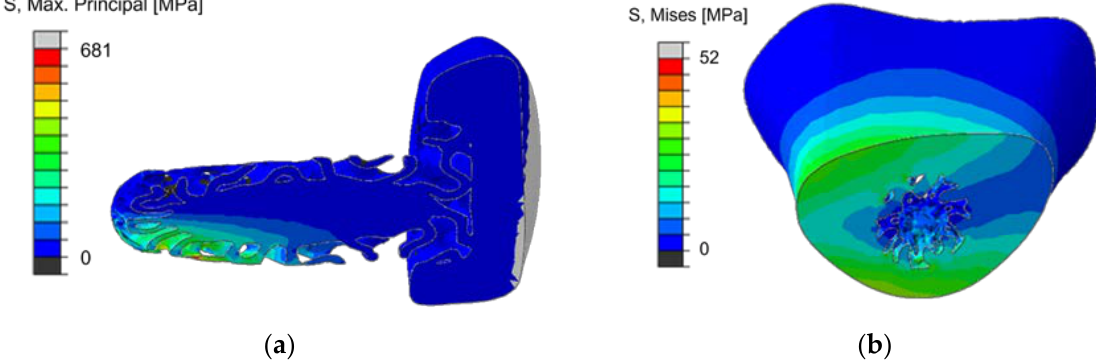
( b ) Figure 14. Index finger implant in proximal bone: ( a ) maximal principal stress when implant is loaded with 45° to bone axis with 2.5 times of 100N reference load; ( b ) probability of survival for each finite element of a defined region. The generated load in the implant is distributed in the form of a bending load deep into the implantation and is essentially determined in the local stress increase by the geo- metric shape of the TPMS SplitP structure following the shape of the implant (Figure 15).